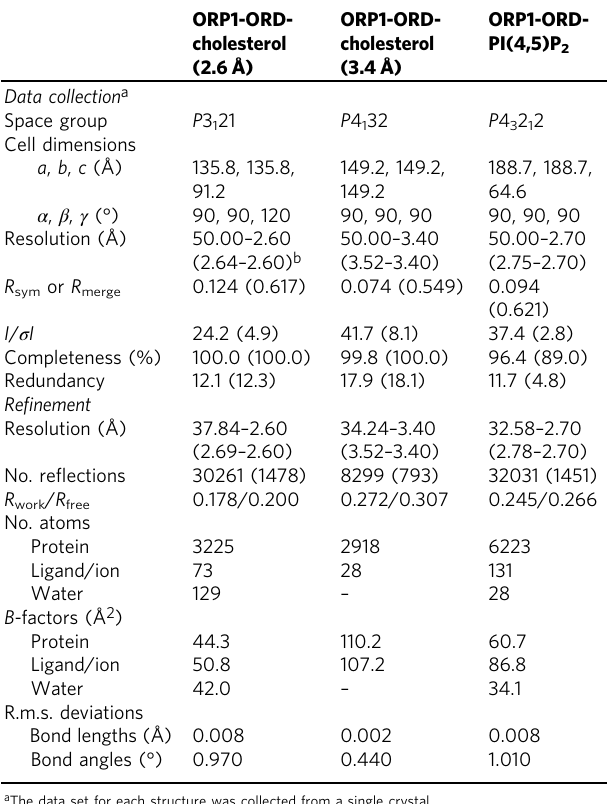
Table 1 Data collection and re fi nement statistics (molecular replacement) ORP1-ORD-